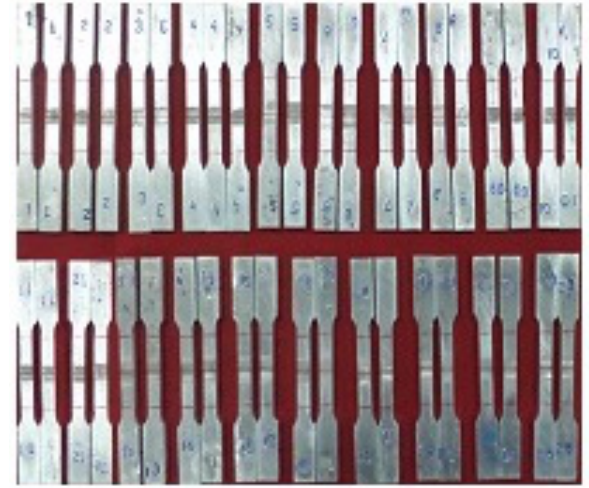
Figure 5: Photograph of tensile specimen (Before testing)